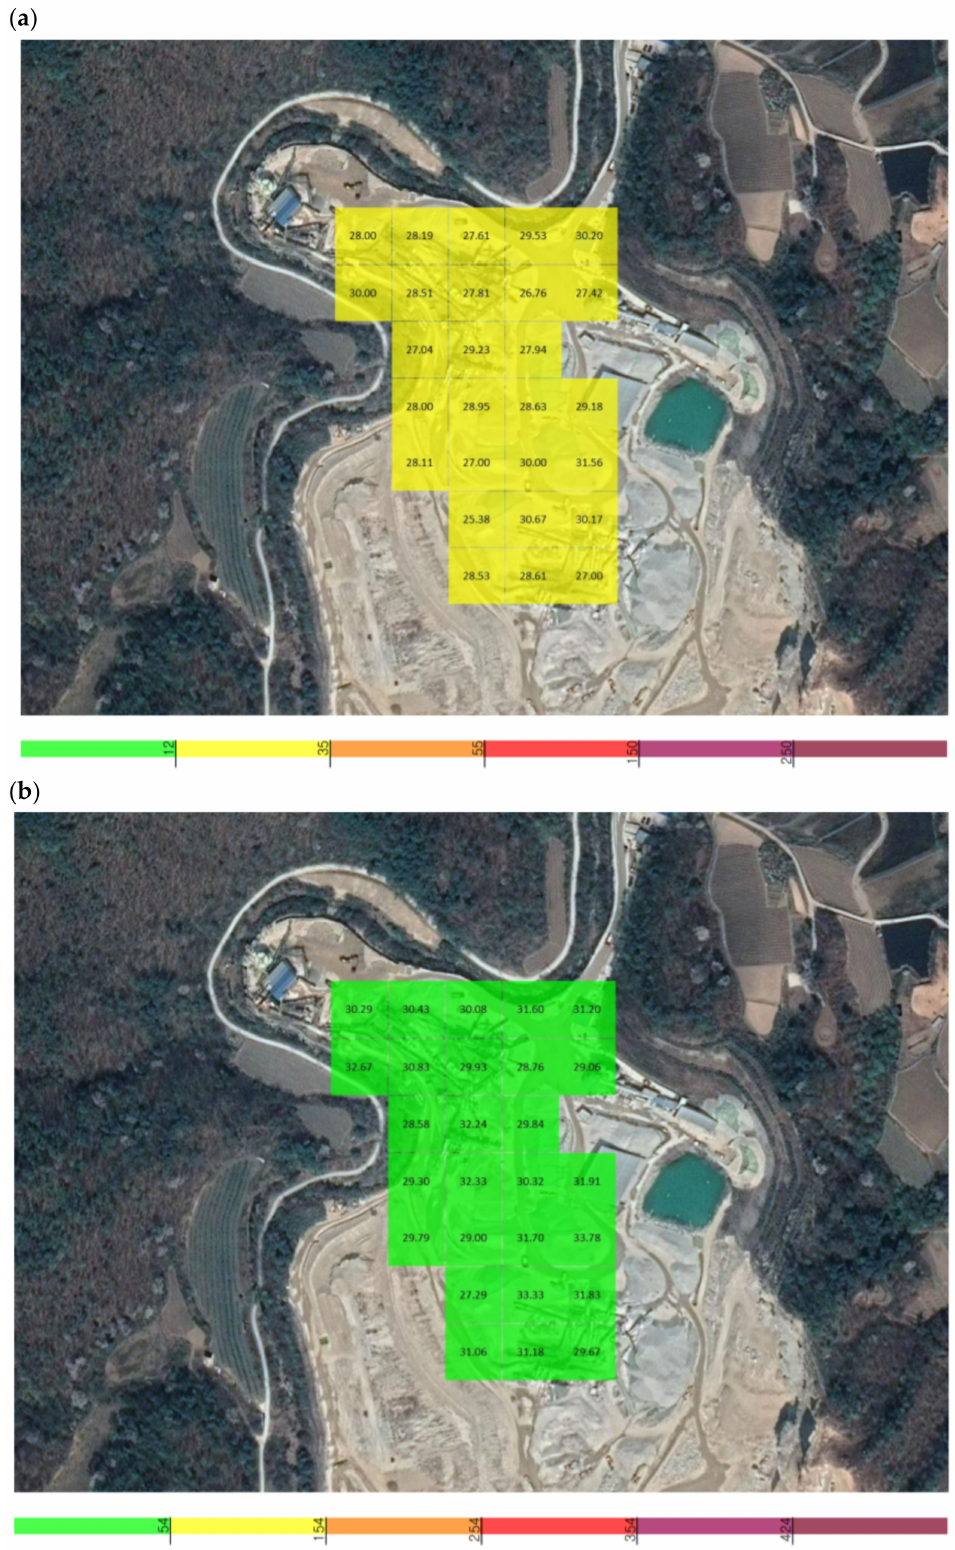
Figure 5. Grid detection area of the unmanned aerial vehicle (UAV) measuring sensor at X